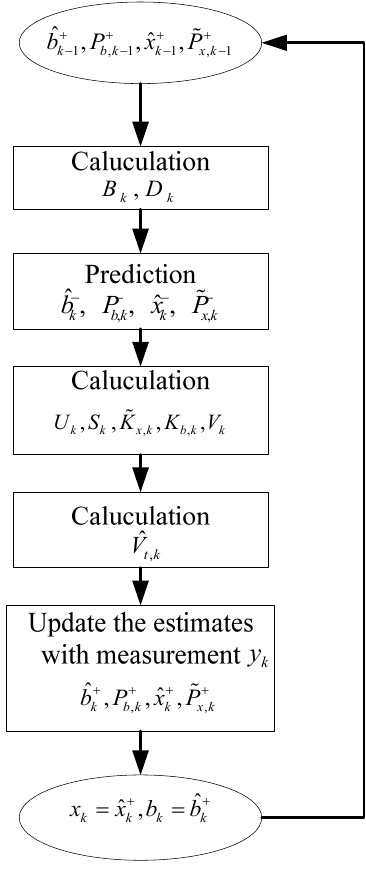
Figure 3. Procedure of the Robust EKF algorithm in SOC